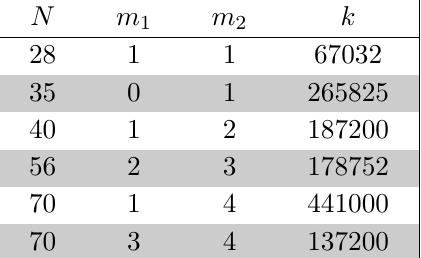
Table 4 . Simultaneous solutions to Diophantine equations for 0 < N ≤ 70